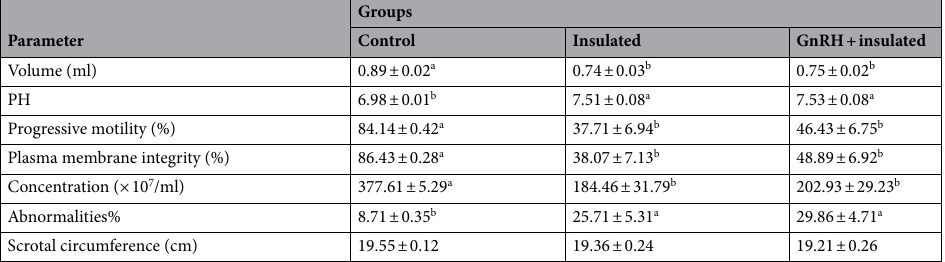
Table 1. Effect of treatment on seminal parameters from bucks subjected to scrotal insulation (INS and GnRH + INS) or not (CON) for 92 days of insulation. a,b,c Means with different small superscript letters in the same row are significantly different ( p < 0.05). (Duncan